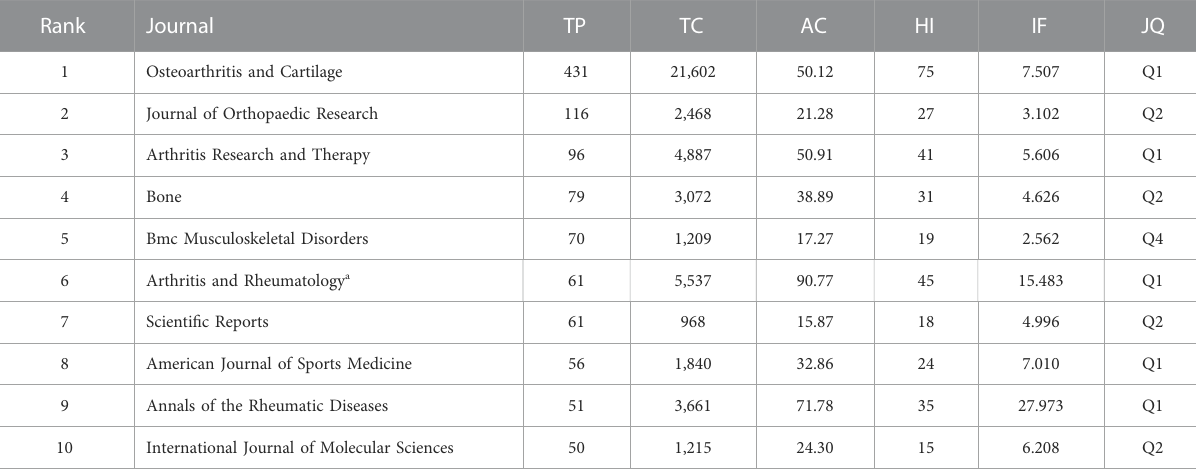
TABLE 3 The top 10 journals contributing to